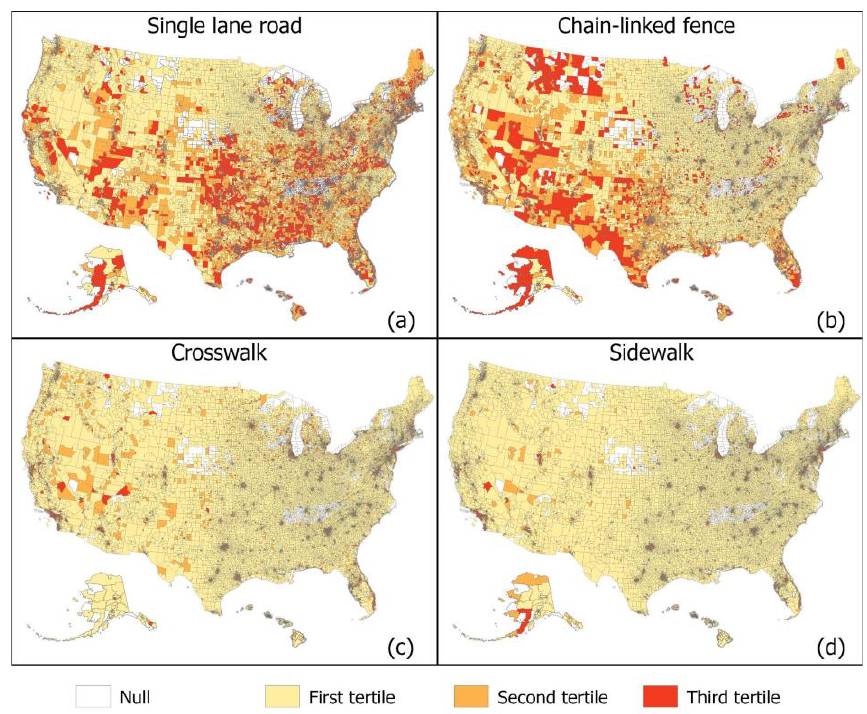
Figure 3. Census tract level distribution of GSV-derived neighborhood characteristics. ( a ) single lane roads, ( b ) chain-link fence, ( c ) crosswalk, ( d ) sidewalk. Darker colors signal higher prevalence of a neighborhood characteristic.